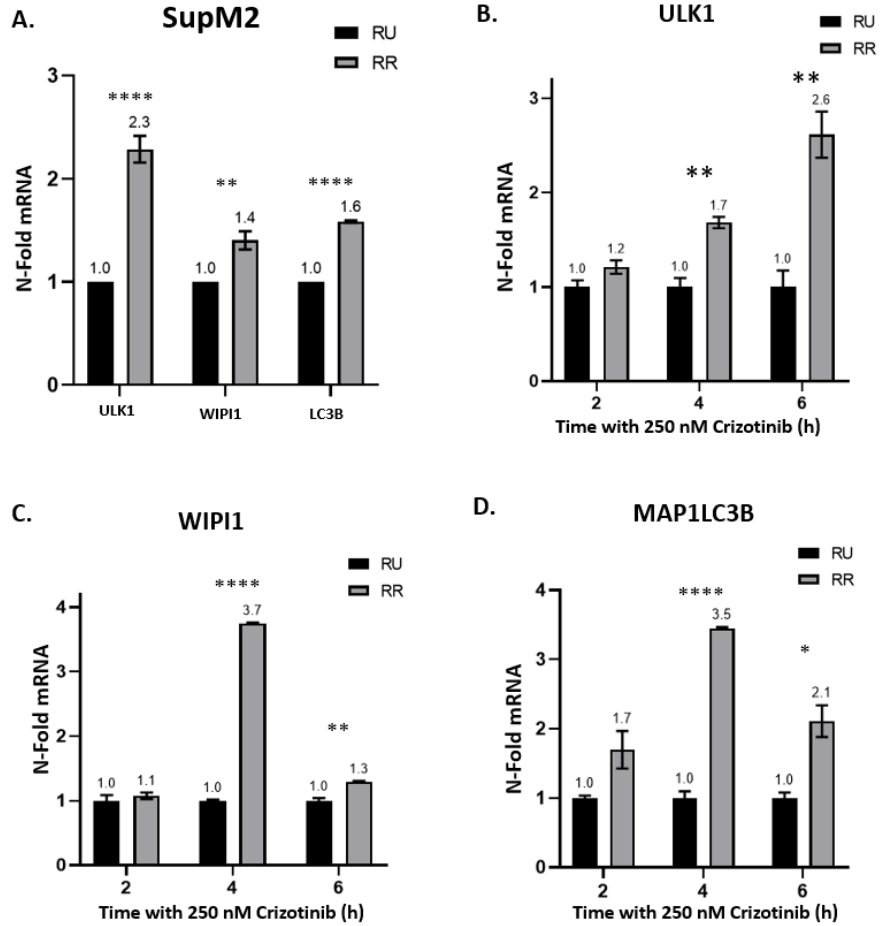
Figure 2. Autophagy related genes highly expressed in SupM2 RR cells compared to RU cells at mRNA level. ( A ) The relative mRNA expression of ULK1, WIPI1, and MAP1LC3B in SupM2 RU and RR cells at steady state. Results were detected by quantitative PCR between SupM2 RU and RR cells. ( B – D ) The relative mRNA expression of ULK1, WIPI1, and MAP1LC3B in SupM2 RU and RR cells treated with 250 nM of crizotinib. Cells were collected 2 h, 4 h, and 6 h after drug treatment. Data normalized to SupM2 RU cells and shown as mean ± standard error of mean (SEM), n = 3; * p < 0.05, ** p < 0.01, **** p < 0.0001, Student’s t test. Three independent experiments were performed.